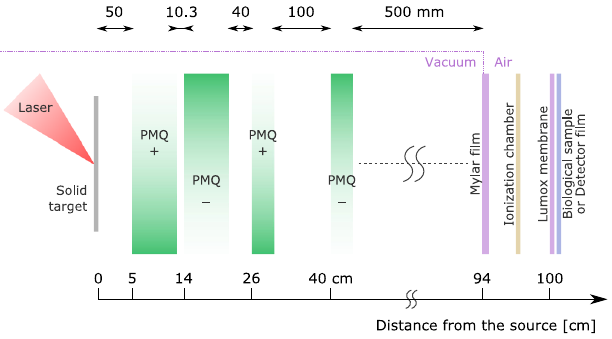
FIG. 2. Sketch of the SAPHIR beam line setup used for proton beam transport studies. The first PMQ is set at the minimal distance of 5 cm from the source. The plus and minus symbols indicate the relative polarity of each PMQ. The 75 μ m Mylar film for vacuum/air separation and the transmission ionization cham- ber are also depicted.